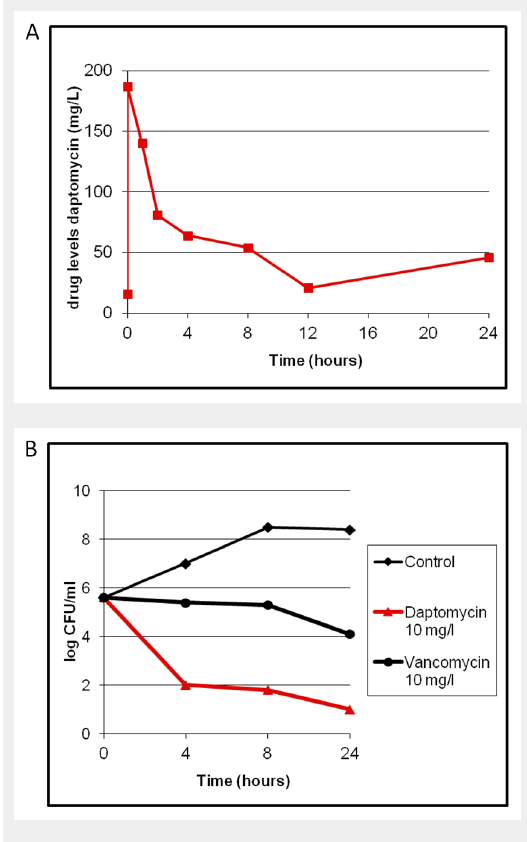
Figure 1 Therapeutic monitoring in one patient with high-dose daptomycin of 10 mg/kg/24 h (A) and in vitro killing curves showing a bactericidal effect of daptomycin at 10 mg/l in contrast to 10 mg/l vancomycin